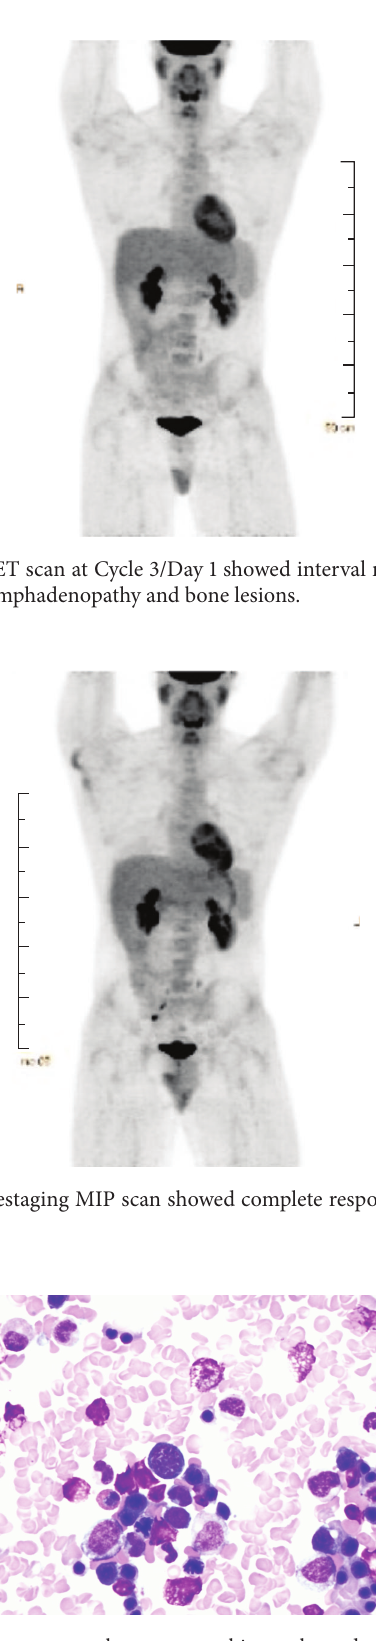
Figure 7: Posttreatment bone marrow biopsy showed mild hypocel- lularity with erythroid hyperplasia and dyspoiesis in the absence of Reed-Sternberg cells or